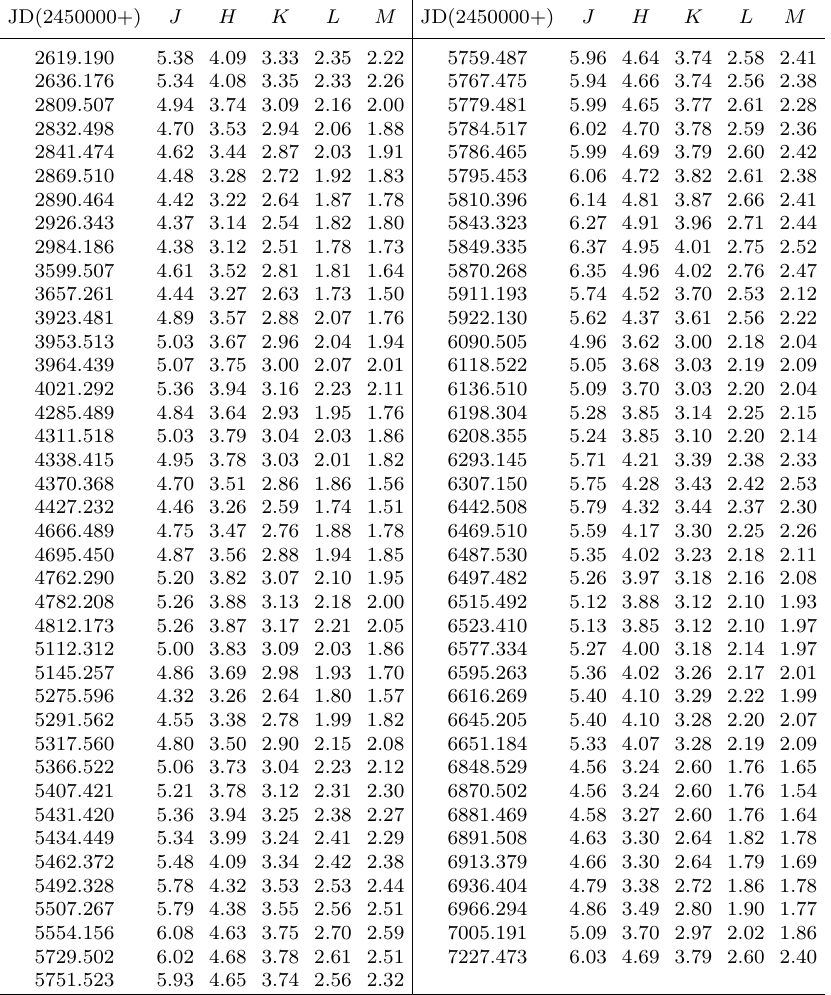
Table 2. JHKLM photometry of V407